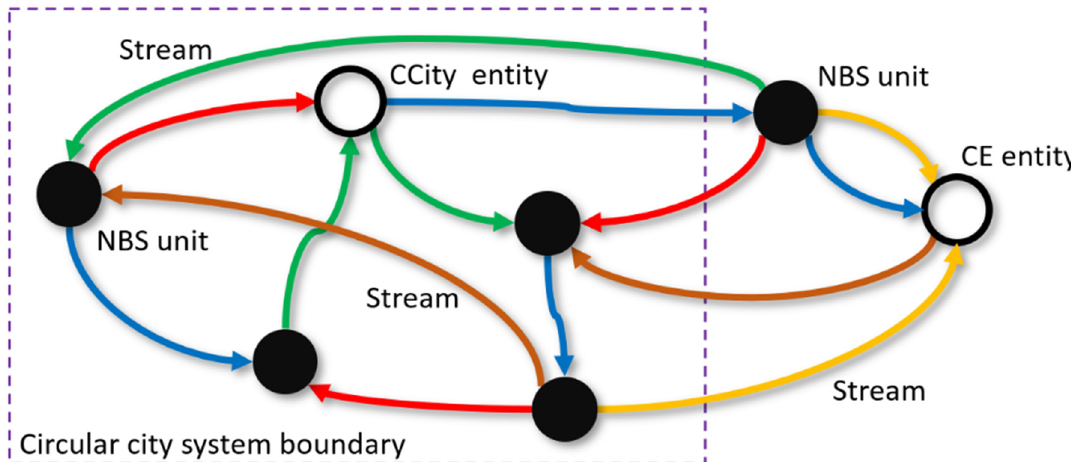
Figure 1. Schematic sketch of a CE network topology with CE and Circular City entities (referred to as “CCity entities”) as black boxes (nodes) and unidirectional resource streams (links). Circular Economy entities (referred to as “CE entities”) within the Circular City system boundary become Circular City entities. All full circles represent NBS units, regardless of the Circular City system boundary. The link colors symbolize the stream types of water, nutrients, biomass, living organisms, and energy but do not represent specific streams in this sketch.